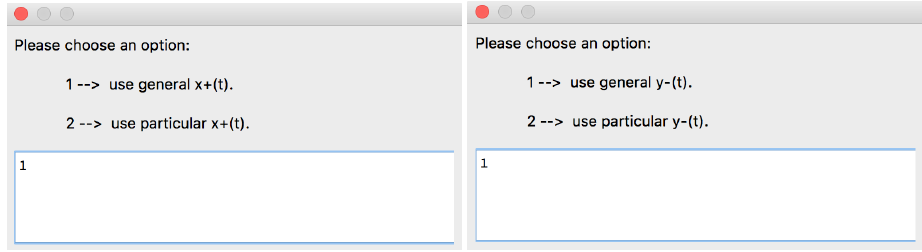
Figure 25. Part of the structure of the [SInt] algorithm corresponding to the input of x + and y − .